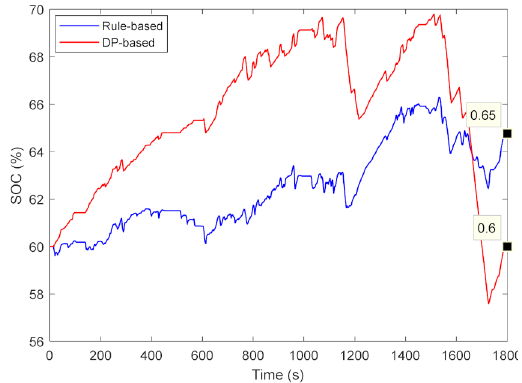
Figure 16. The changing trend of SOC . The simulation results of the rule- and DP-based strategies are compared in Table 2.